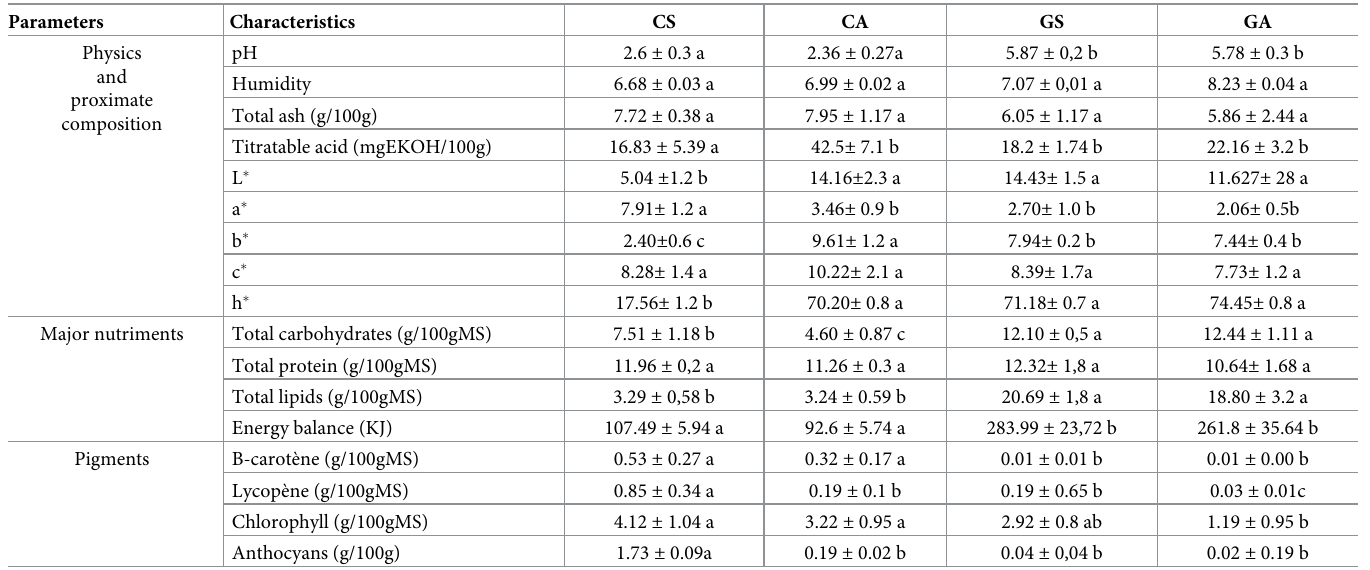
Table 1. Physics and proximate, major nutriments, pigments contents.